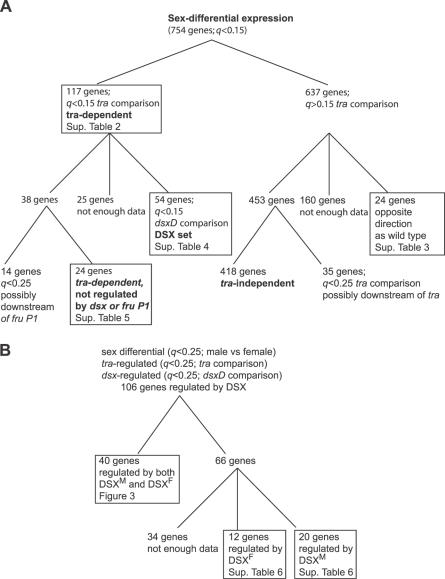
Overview of Results from Statistical Tests Performed on Microarray Data(A) Overview of results from statistical tests of microarray data leading to the identification of sex-differentially expressed genes regulated by tra, dsx, or neither in adult head tissues.(B) Overview of results from statistical tests of microarray data leading to the identification of genes regulated downstream of DSX activity and the modes of DSX regulation for these genes.doi:0.1371/journal.pgen.0030216.g002